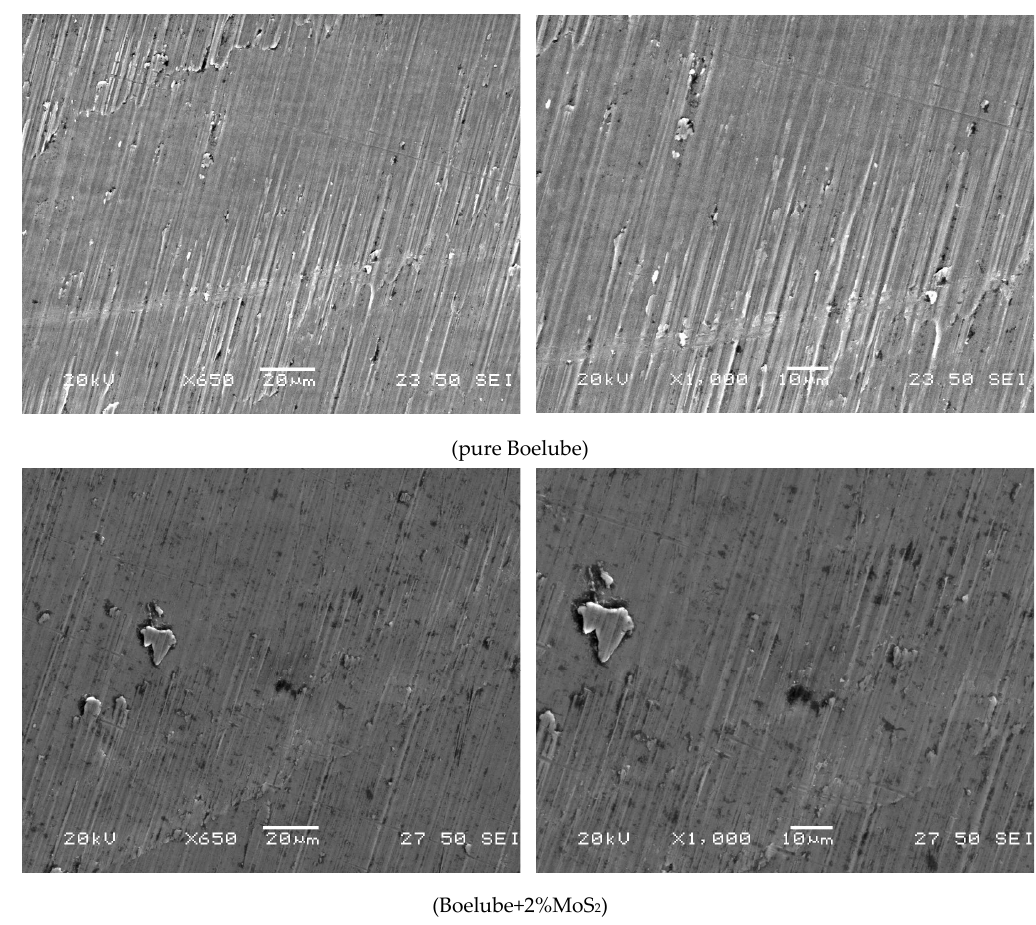
Figure 7. SEM micrographs of Ti workpiece surfaces machined using Boelube and Boelube+2%MoS 2 .